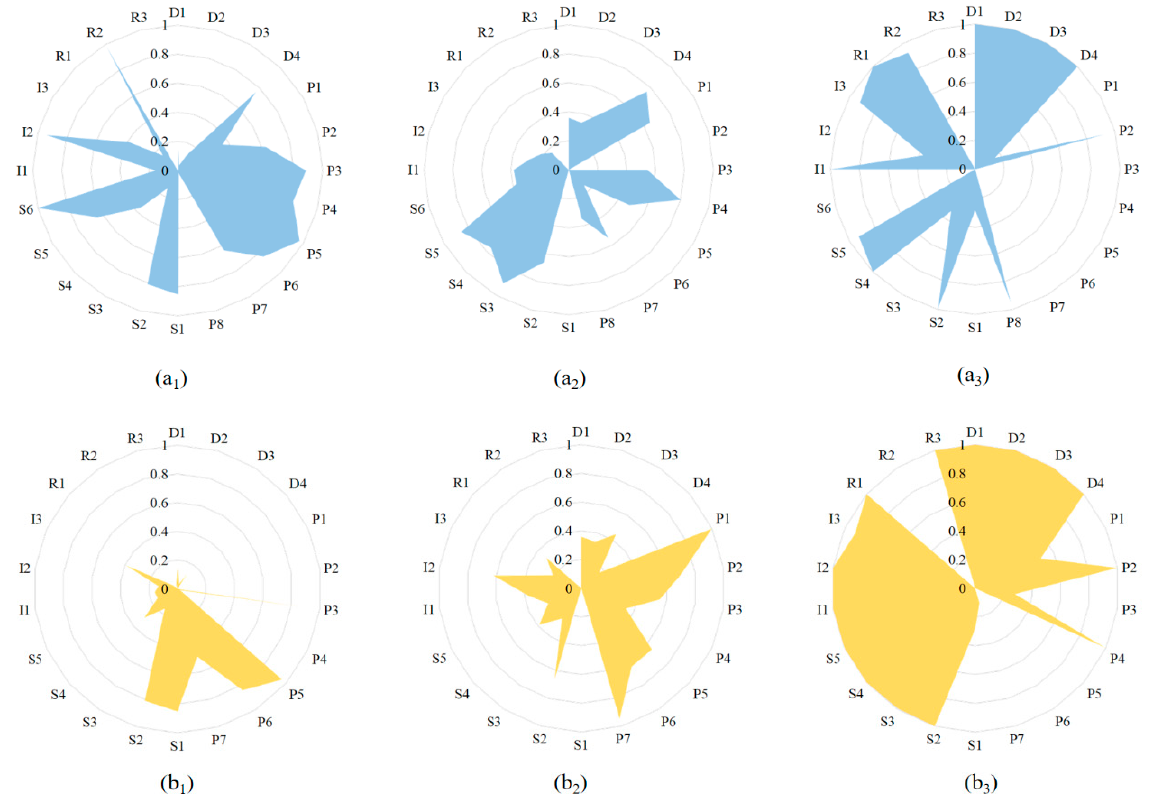
Figure 8. Normalized data of the WALR indexes: ( a 1 , a 2 , a 3 ) normalized data of the water resources subsystem indexes in 2010, 2014 and 2019, respectively; ( b 1 , b 2 , b 3 ) normalized data of the land resources subsystem indexes in the corresponding years.